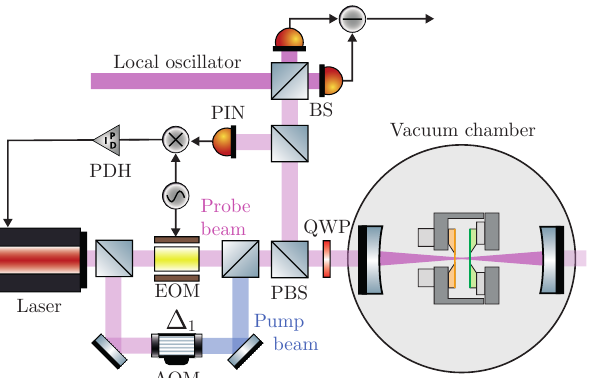
Figure 2. Experimental setup to explore the linear and non-linear dynamics of an optomechanical system made up of a two-membrane etalon inserted in the middle of a high finesse Fabry–Pérot cavity. A probe beam, phase modulated by an electro-optical modulator (EOM), impinges on the optical cavity. It is frequency locked to the cavity resonance frequency using the Pound–Drever–Hall (PDH) technique. The reflected beam is analyzed by homodyne detection to measure the mechanical motion of the resonators. An acousto-optic modulator (AOM) detunes the pump beam by ∆ 1 from the resonance frequency of the cavity. When switched on, the optomechanical interaction is engineered. BS denotes a beam-splitter, PBS a polarizing beam-splitter, QWP a quarter-waveplate, and HWP a